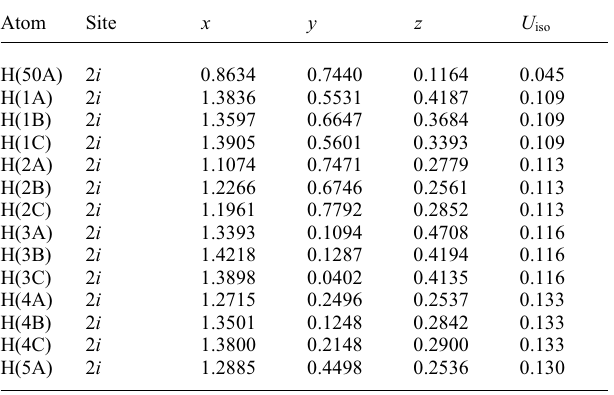
Table 2. Atomic coordinates and displacement parameters (in Å 2 ) .